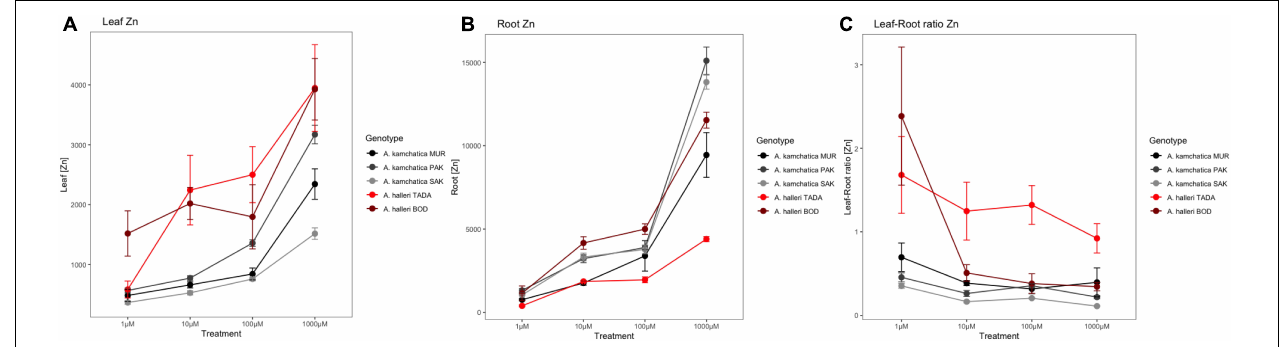
FIGURE 4 | Accumulation of Zn in the leaves (A) and roots (B) of A. halleri and A. kamchatica over a 10-fold gradient of Zn concentrations. Points and lines are color coded as follows: A. halleri (TADA, red) and three A. kamchatica genotypes (PAK, light gray; SAK, dark gray; and MUR, black) at four Zn treatment conditions (1, 10, 100, and 1,000 µ M). The ratio of leaf-to-root Zn accumulation at each treatment condition is shown in (C) .